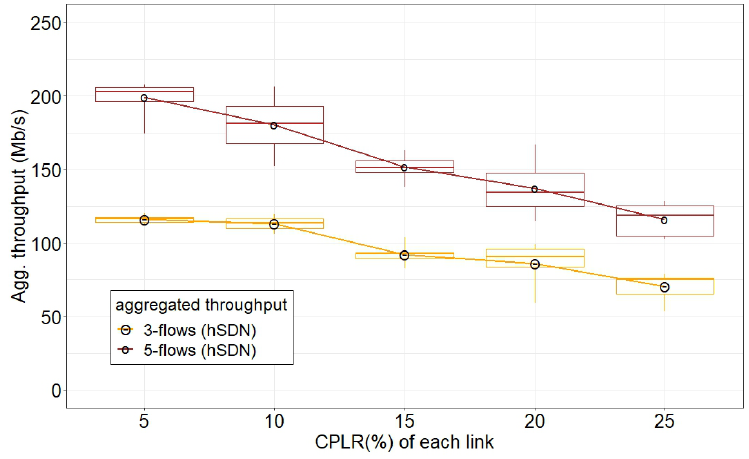
Figure 18. Data plane performance (aggregated throughput) of hSDN during data plane link failures for various times under unreliable control plane conditions in a 16-node grid